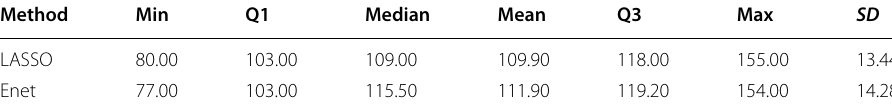
Q1, quartile 1; Q3, quartile 3